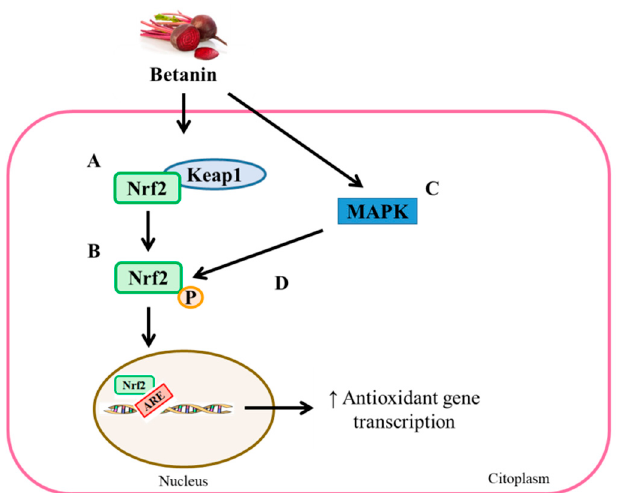
Figure 4. Antioxidant effects induced by betanins through Nrf2. Betanins enhance the Nrf2-Keap1 complex dissociation ( A ) and enhance Nrf2 nuclear translocation ( B ). Additionally, betanins can also activate MAPK ( C ), which, in turn, phosphorylates and stabilizes Nrf2 ( D ), contributing to its nuclear translocation. As a result, nuclear Nrf2-ARE binding is increased, resulting in enhanced transcription of genes encoding antioxidant and phase II enzymes. ARE: antioxidant response element, Keap1: Kelch-like repressor protein ECH-associated protein 1, MAPK: mitogen-activated protein kinase and Nrf2: nuclear factor erythroid 2-related factor 2.